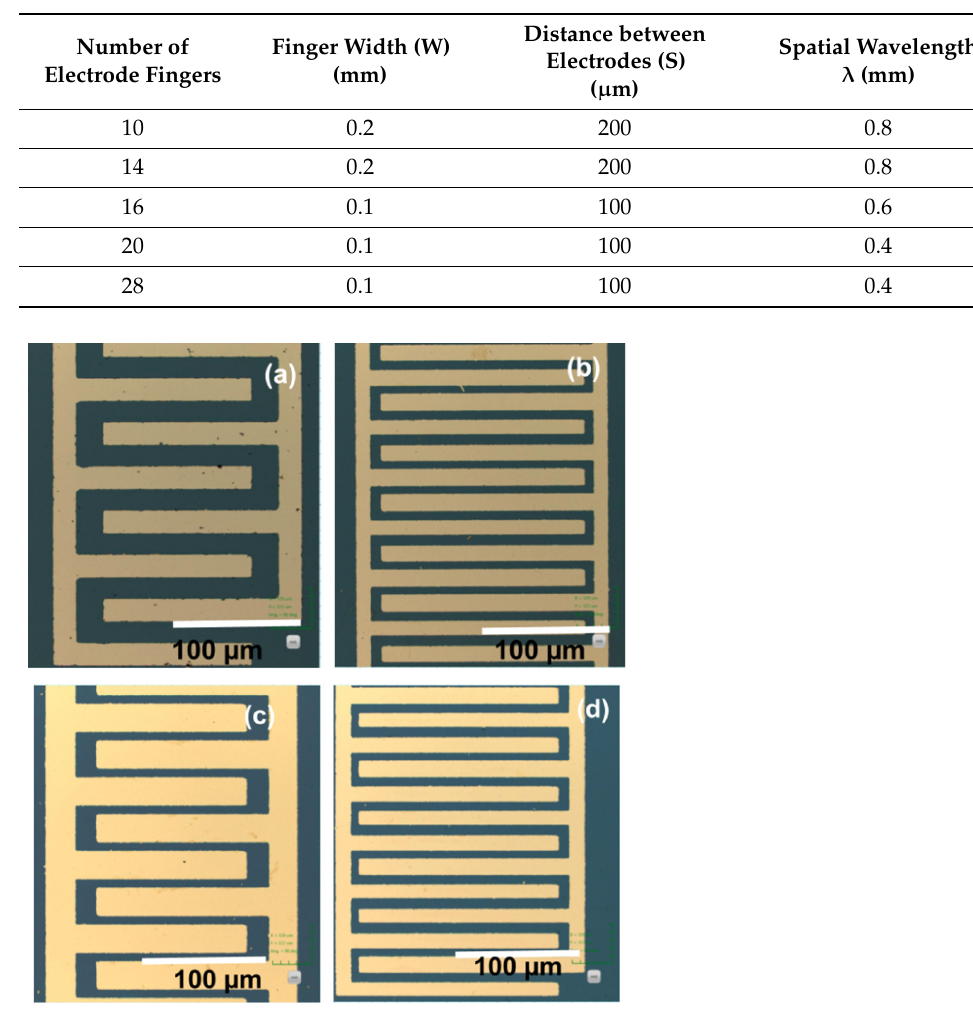
Table 1. Comparison of different combinations of ide for same dimension of 6 mm × 3 mm sensor.